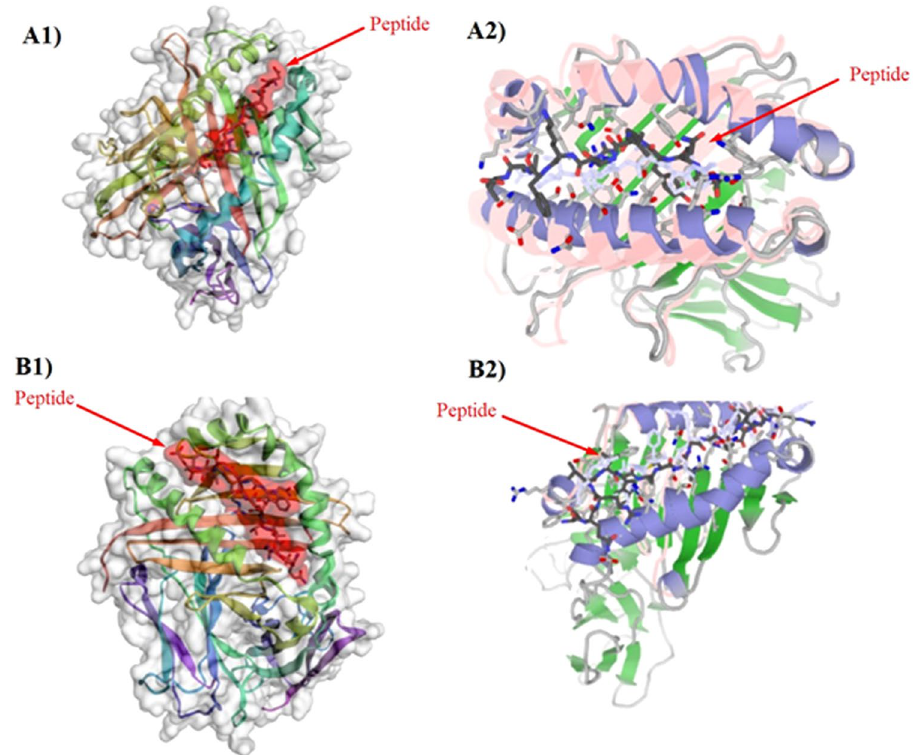
Figure 1. ( A1 ) Successful peptide-protein Docking between L1 12–21 (YLPPVPVSKV) and HLA 0301 with cluster density scores of 214.7; ( A2 ) Successful peptide-protein Docking between L1 12–21 (YLPPVPVSKV) and HLA 0301 with interaction similarity scores of 215; ( B1 ) Successful peptide-protein Docking between L2 100–118 and HLA DRB1–0101 with cluster density of 121.06; ( B2 ) Successful peptide-protein Docking between L2 100–118 and HLA DRB1–0101 with interaction similarity scores of